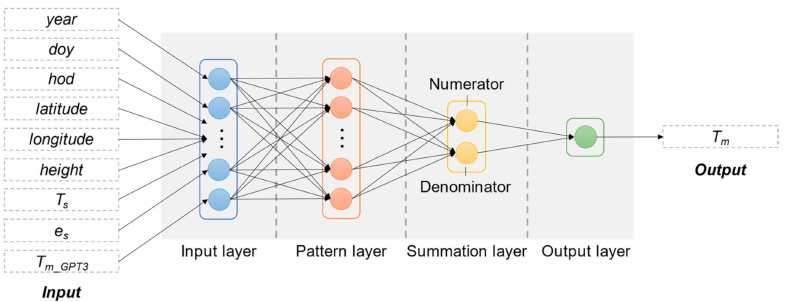
Figure 3. Structure of generalized regression neural network